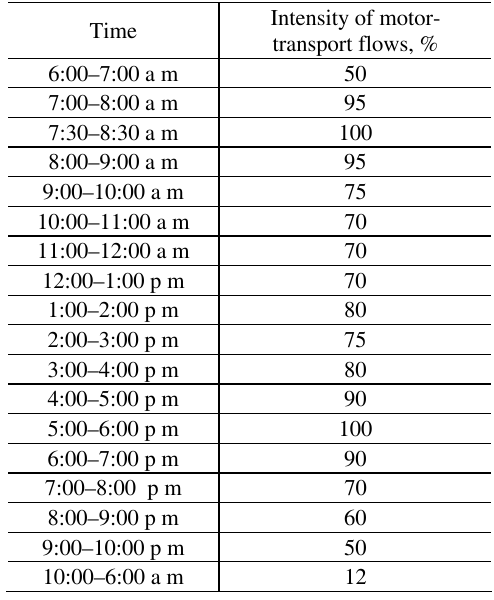
Table 3 . Intensity of motor transport flows during the